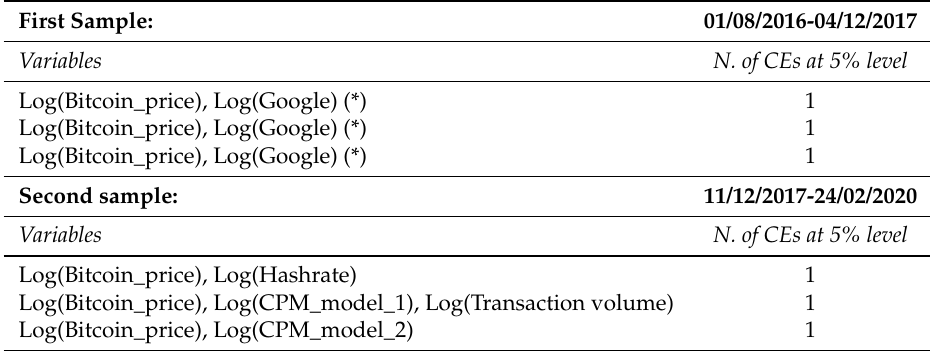
Table 7. Multivariate Johansen cointegration tests. The null hypothesis is the absence of cointegration. The tests considered either the case of an intercept in the cointegration equation (CE) and a trend in the variables (first sample) or the case of an intercept in the CE only (second sample). (*) The final model turned out to be the same, independently of whether we used the hashrate, or the CPM1, or the